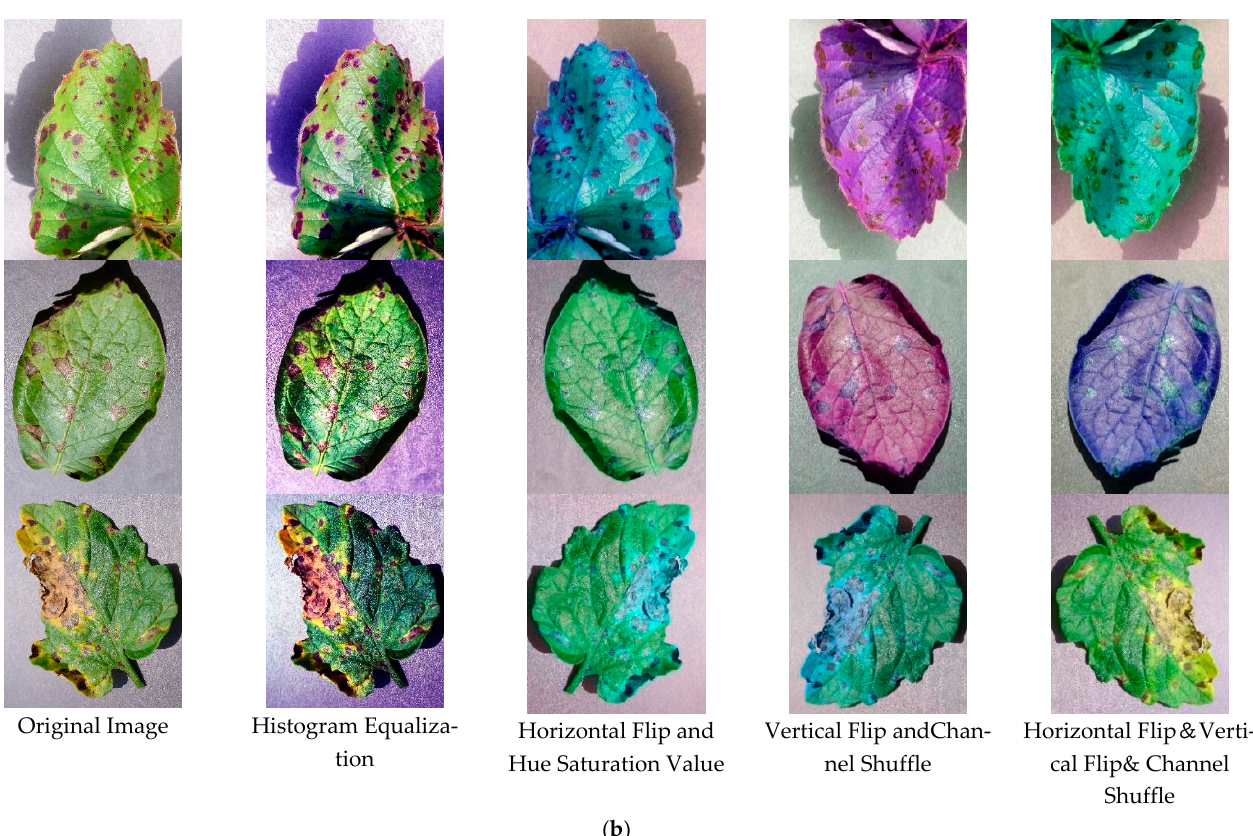
Figure 8. Data Enhancement. ( a ) Positive sample (healthy); ( b ) Negative sample (Diseases).